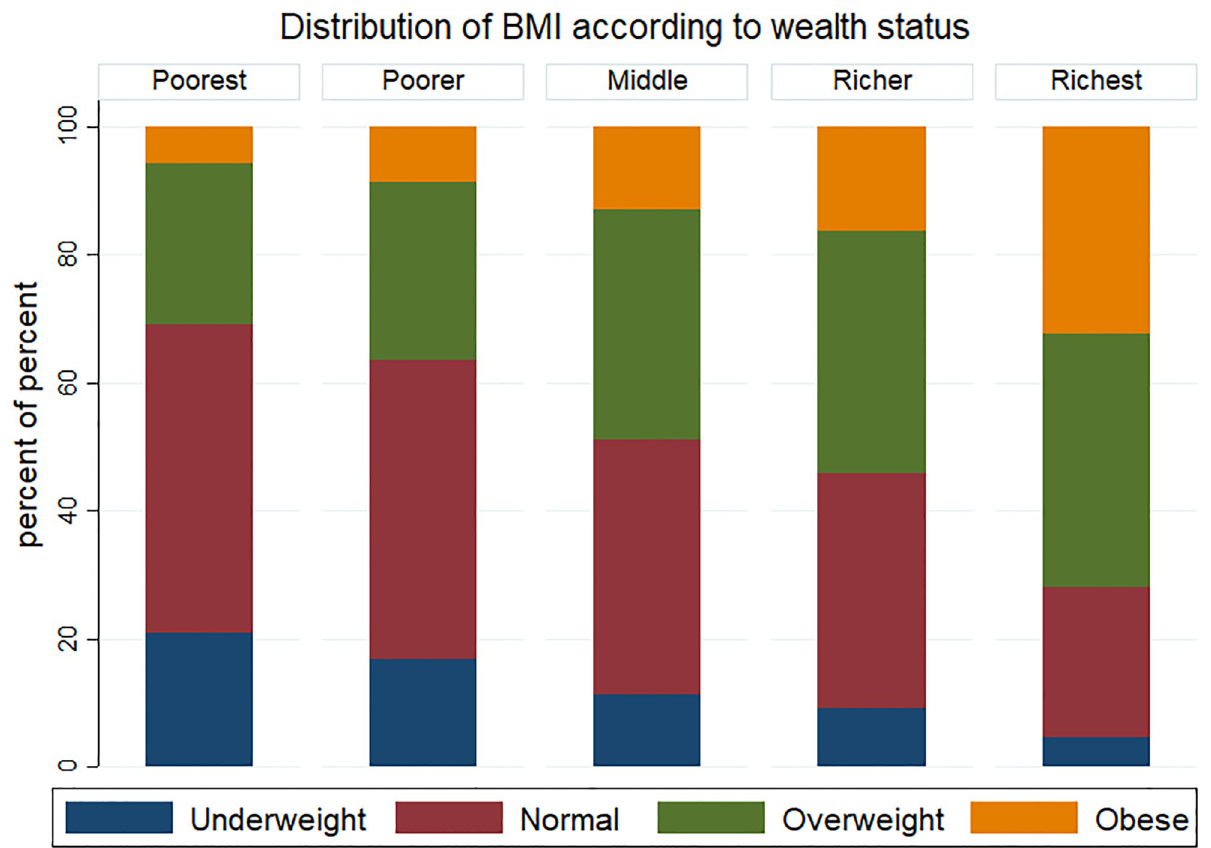
Fig 1. Distribution of body mass index (BMI) according to the wealth index of reproductive-aged (15–49 years) women of Bangladesh.